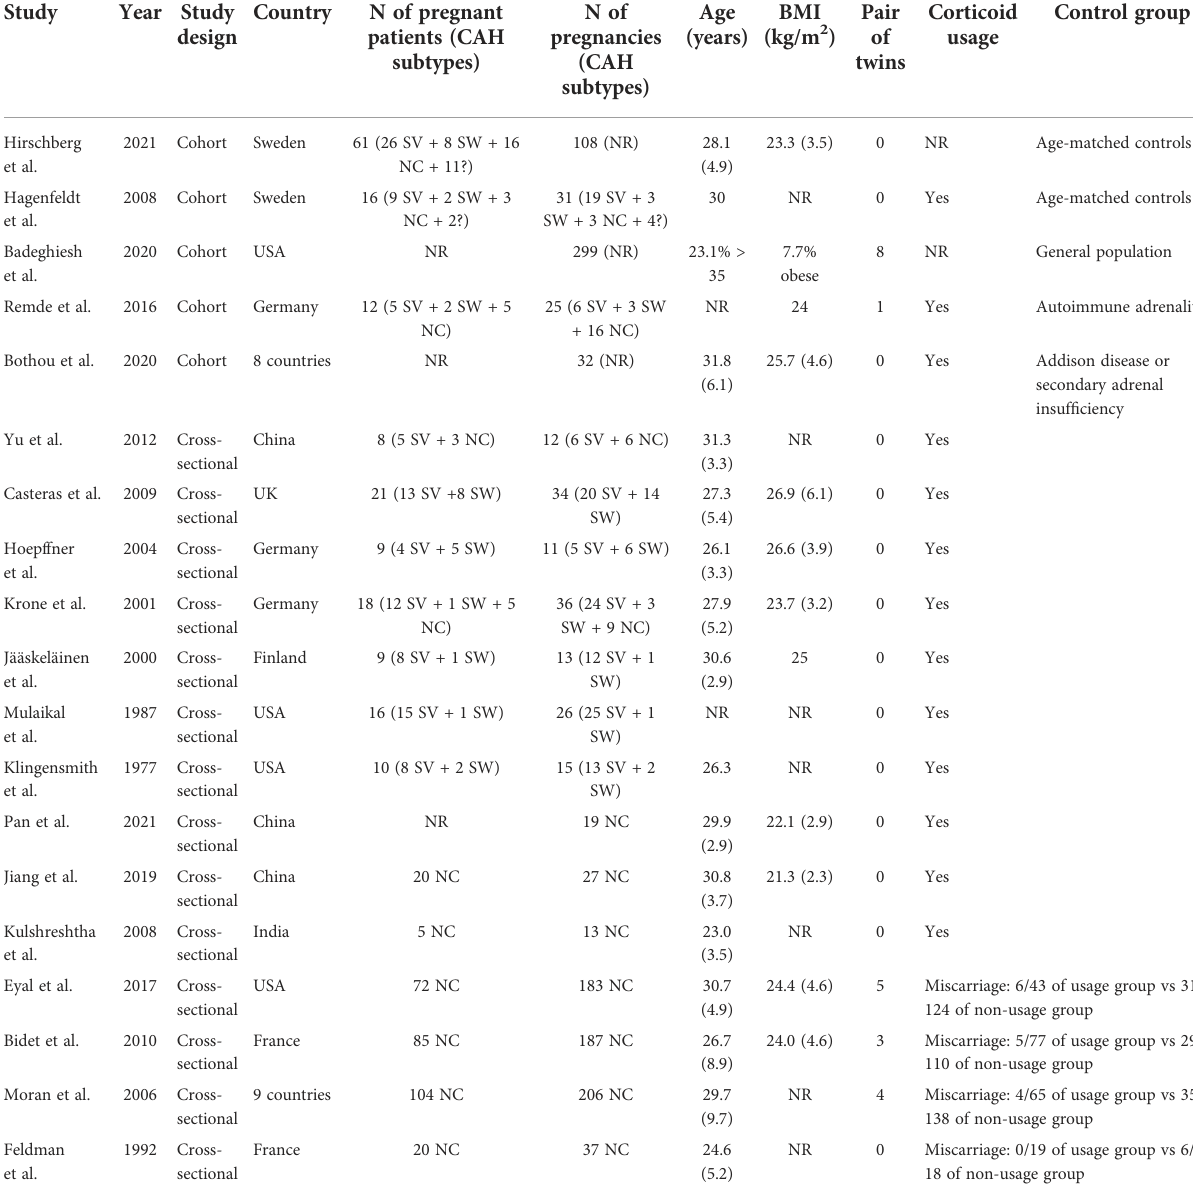
TABLE 2 Characteristics of studies included in the meta-analysis.